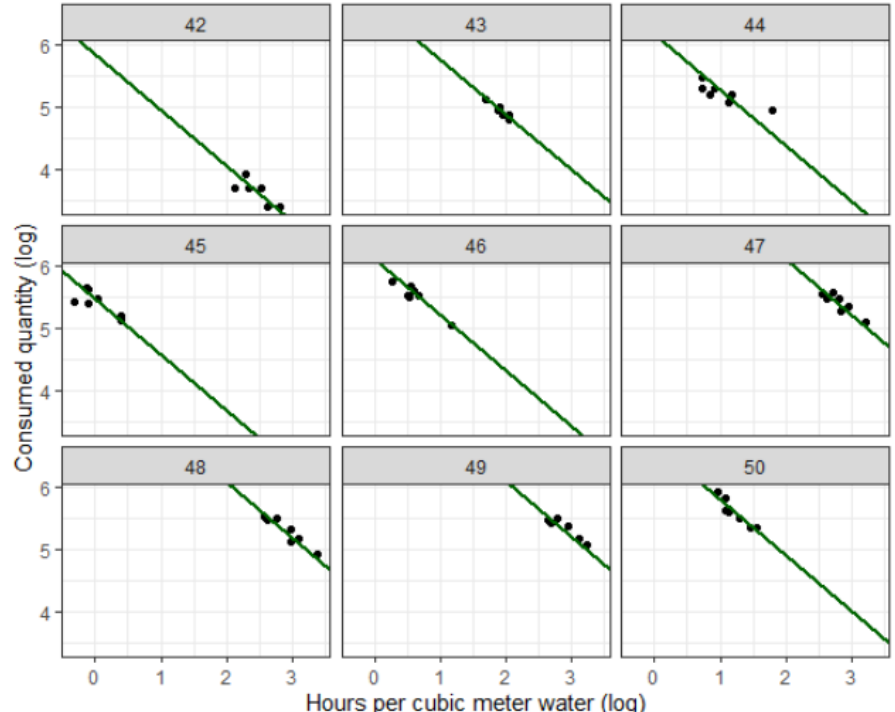
Figure A2. Log-transformed data points of nine households and the fitted regression line for Model A, to illustrate the variability introduced by the random intercepts.